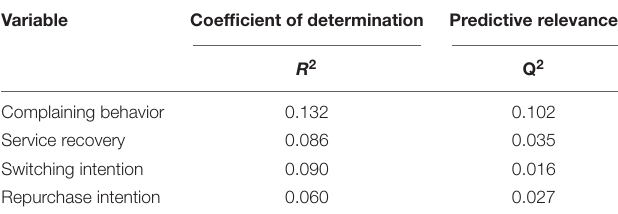
TABLE 7 | Predictive relevance and coefficient of